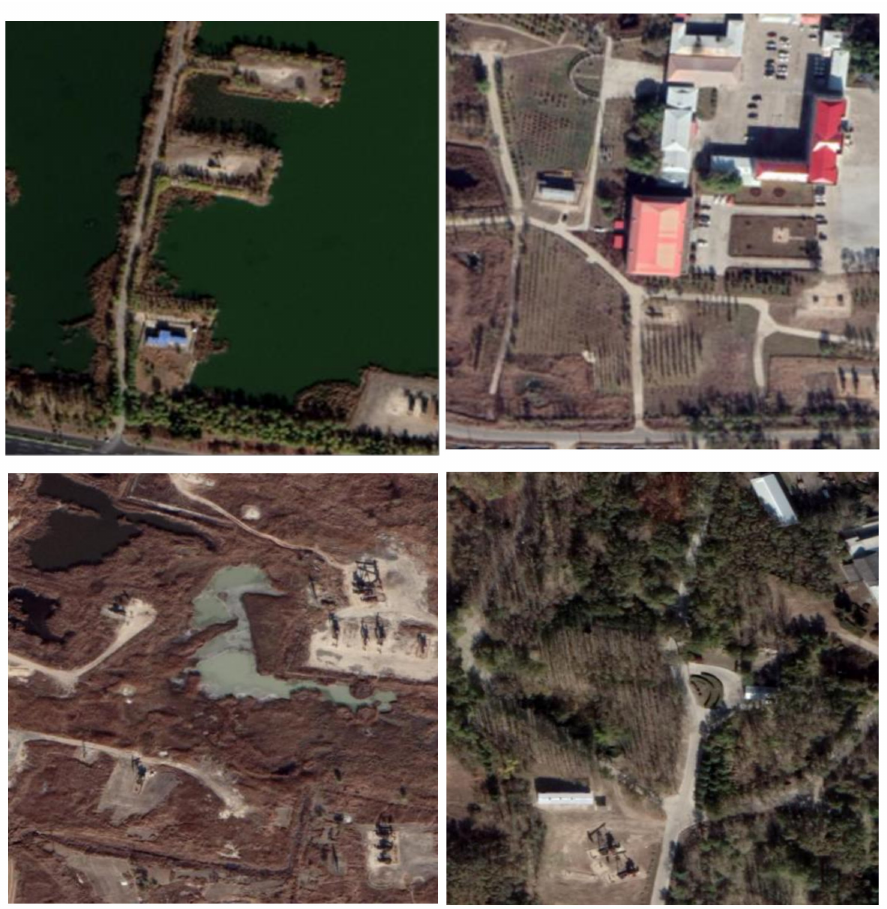
Figure 6. Sample images from NEPU–OWOD V1.0